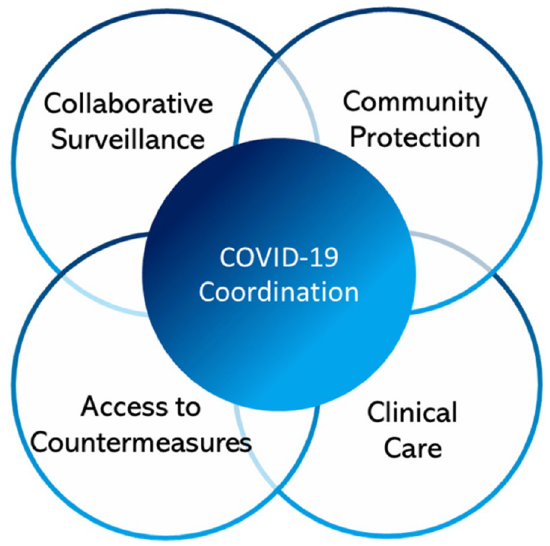
Fig. 1 Five core components of pandemic